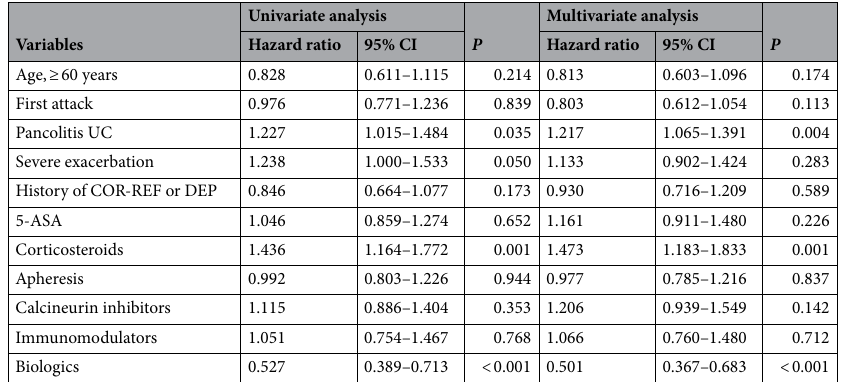
Table 4. Cox regression analysis of the factors for cumulative risk of re-exacerbation in patients with moderate to severe UC exacerbations.